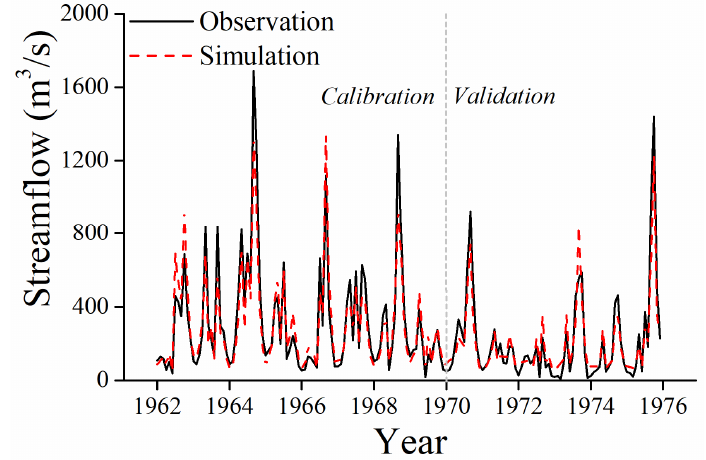
Figure 2. Monthly simulated streamflow against observed streamflow of Huaxian station for the calibration period (1962–1969) and validation period (1970–1976).